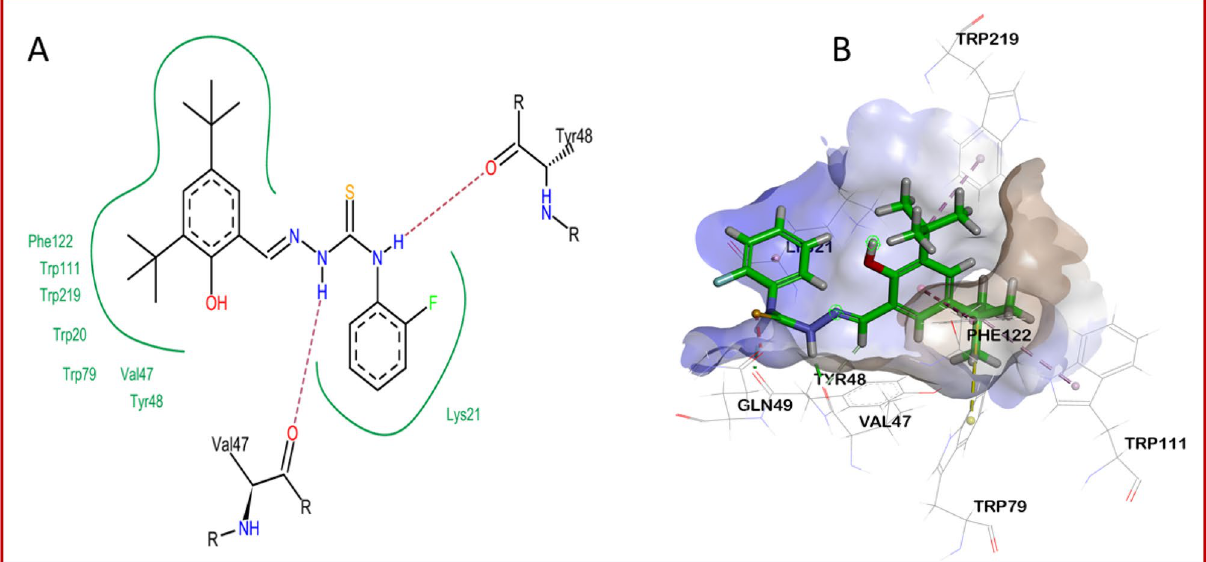
Figure 4. Two- and three-dimensional views of the interactions of 3m within the active site of AKR1B1 are shown. ( A ) Two dimensional interactions show the involvement of Val47 and Tyr48 in hydrogen bond formation with the inhibitor. ( B ) Overall three-dimensional interaction poses showing all interacting amino acids residues within the active site.